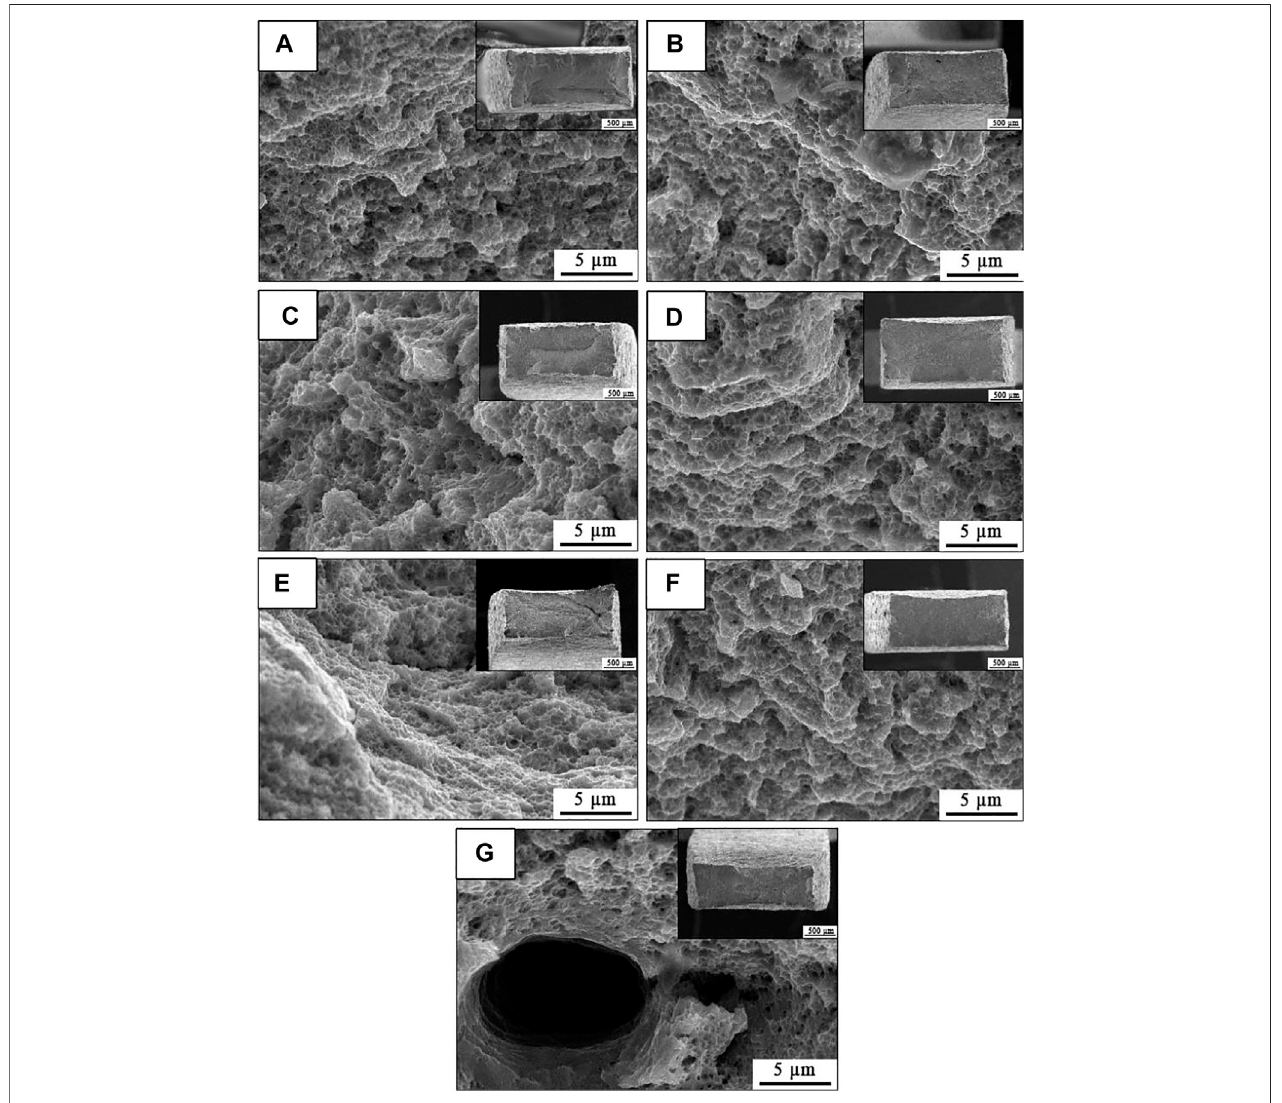
FIGURE9| CharacterizationoffracturesurfaceoftheSLM-processed316LSSfromdifferentanglesrelativetothebuildsubstrate: (A – G) angleof0,15,30,45,60, 75, and 90.